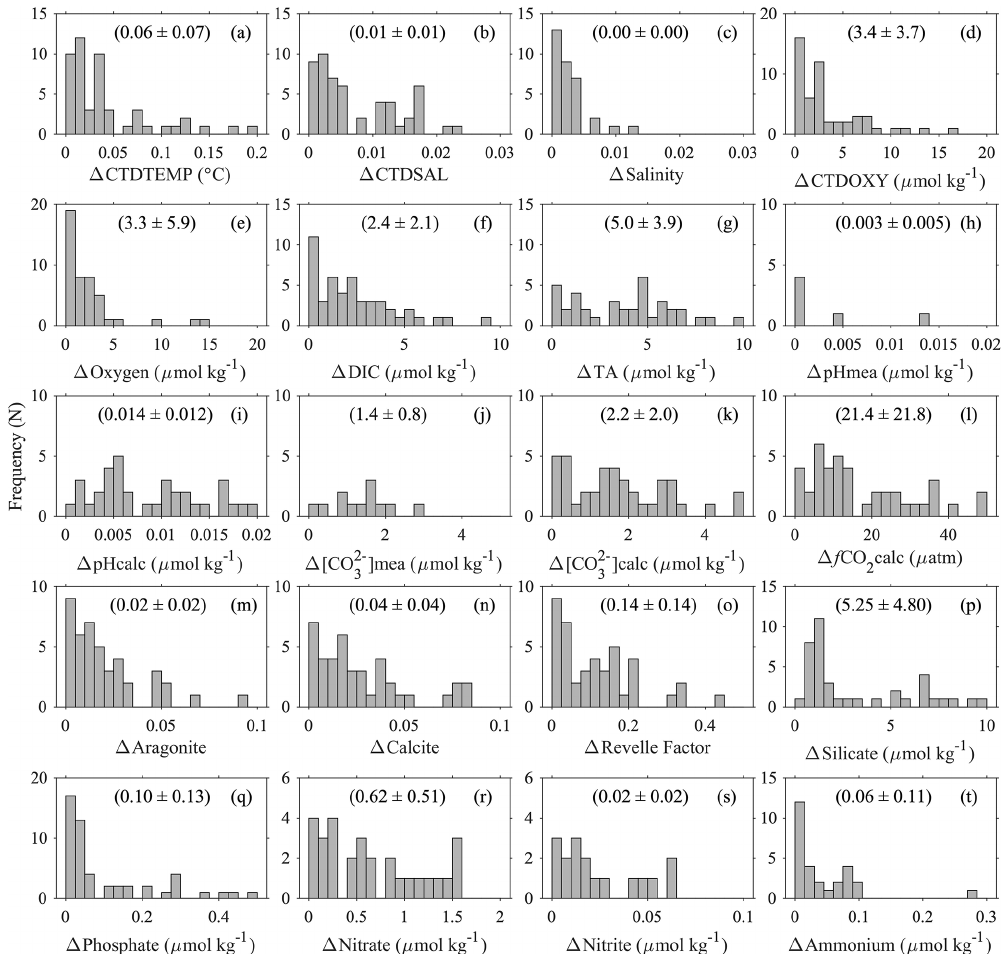
Figure 7. Uncertainties of some parameters based on deep-water comparison analyses: (a) temperature (ITS-90) measured with CTD sensors; (b) salinity (PSS78) measured with CTD sensors; (c) discrete salinity (PSS78); (d) dissolved oxygen measured with CTD sensors; (e) dissolved oxygen content measured with Winkler titration; (f) dissolved inorganic carbon content; (g) total alkalinity; (h) pH on total scale measured with spectrophotometers; (i) pH on total scale calculated from DIC, TA, and other parameters; (j) carbonate ion content measured with spectrophotometers; (k) – (o) carbonate ion content, fugacity of carbon dioxide, aragonite saturation state, calcite saturation state, and Revelle factor calculated from DIC, TA, and other parameters; and (p) – (t) Silicate, Phosphate, Nitrate, Nitrite, and Ammonium contents. The y axis, “frequency (N)”, refers to the number of groups of stations. The values inside the parentheses are mean values ± standard